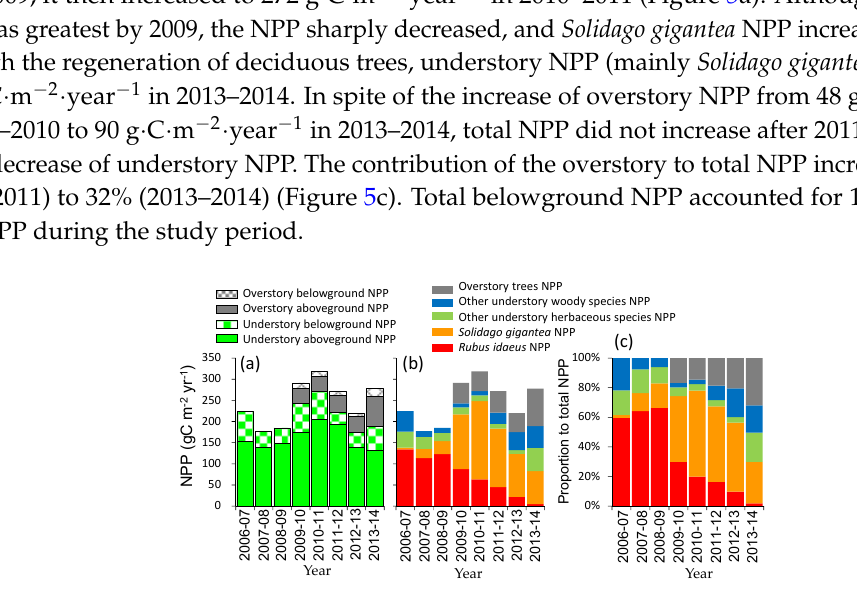
Figure 5. Annual net primary production (NPP) during September–August ( a ) by aboveground and belowground parts; ( b ) by species; and ( c ) the proportion by species.